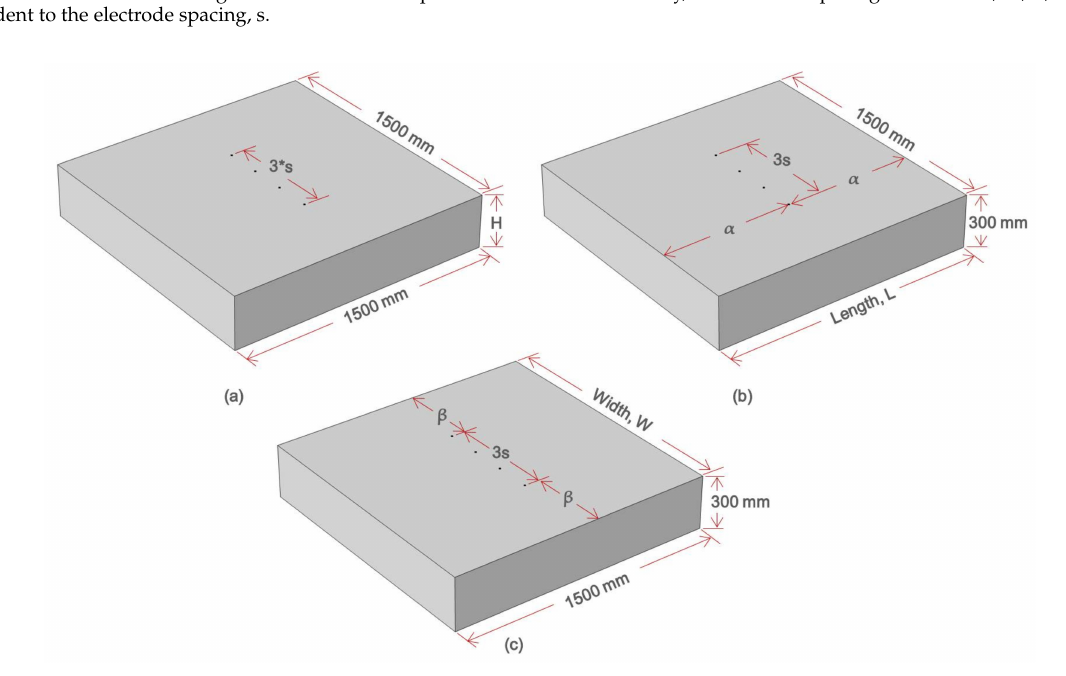
Figure 3. Concrete model with different geometric and probe configuration for the three simulation cases: ( a ) Case 1, ( b ) Case 2, and ( c ) Case